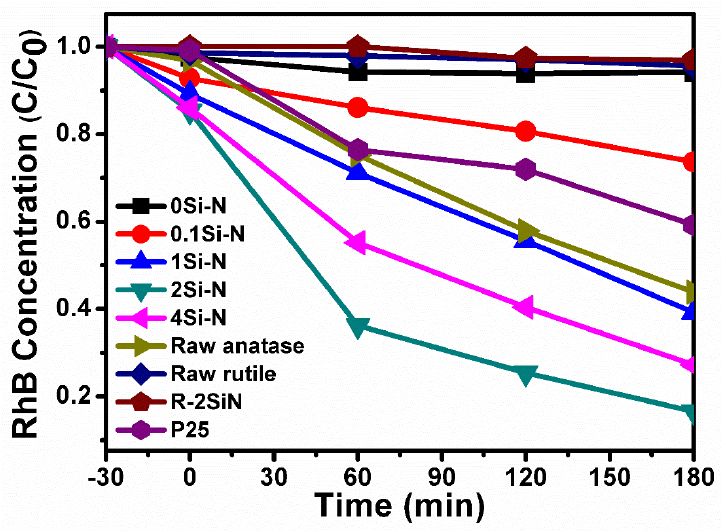
Figure 10. Photocatalytic degradation of RhB using the produced samples and raw anatase and rutile powders.